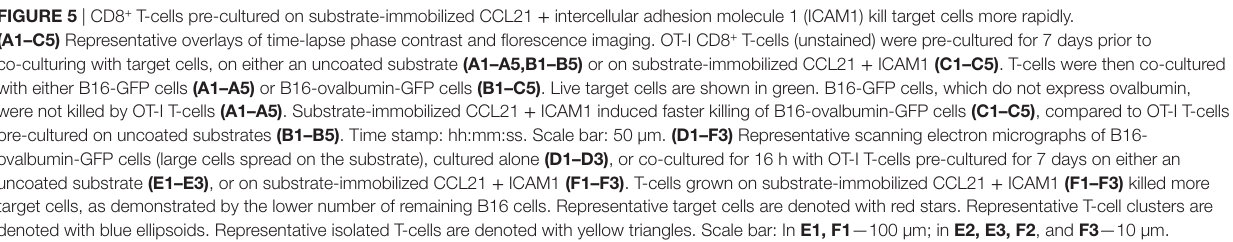
FigUre 5 | CD8 + T-cells pre-cultured on substrate-immobilized CCL21 + intercellular adhesion molecule 1 (ICAM1) kill target cells more rapidly. (a1–c5) Representative overlays of time-lapse phase contrast and florescence imaging. OT-I CD8 + T-cells (unstained) were pre-cultured for 7 days prior to co-culturing with target cells, on either an uncoated substrate (a1–a5,B1–B5) or on substrate-immobilized CCL21 + ICAM1 (c1–c5) . T-cells were then co-cultured with either B16-GFP cells (a1–a5) or B16-ovalbumin-GFP cells (B1–c5) . Live target cells are shown in green. B16-GFP cells, which do not express ovalbumin, were not killed by OT-I T-cells (a1–a5) . Substrate-immobilized CCL21 + ICAM1 induced faster killing of B16-ovalbumin-GFP cells (c1–c5) , compared to OT-I T-cells pre-cultured on uncoated substrates (B1–B5) . Time stamp: hh:mm:ss. Scale bar: 50 µm. (D1–F3) Representative scanning electron micrographs of B16- ovalbumin-GFP cells (large cells spread on the substrate), cultured alone (D1–D3) , or co-cultured for 16 h with OT-I T-cells pre-cultured for 7 days on either an uncoated substrate (e1–e3) , or on substrate-immobilized CCL21 + ICAM1 (F1–F3) . T-cells grown on substrate-immobilized CCL21 + ICAM1 (F1–F3) killed more target cells, as demonstrated by the lower number of remaining B16 cells. Representative target cells are denoted with red stars. Representative T-cell clusters are denoted with blue ellipsoids. Representative isolated T-cells are denoted with yellow triangles. Scale bar: In e1, F1 —100 µm; in e2, e3, F2 , and F3 —10